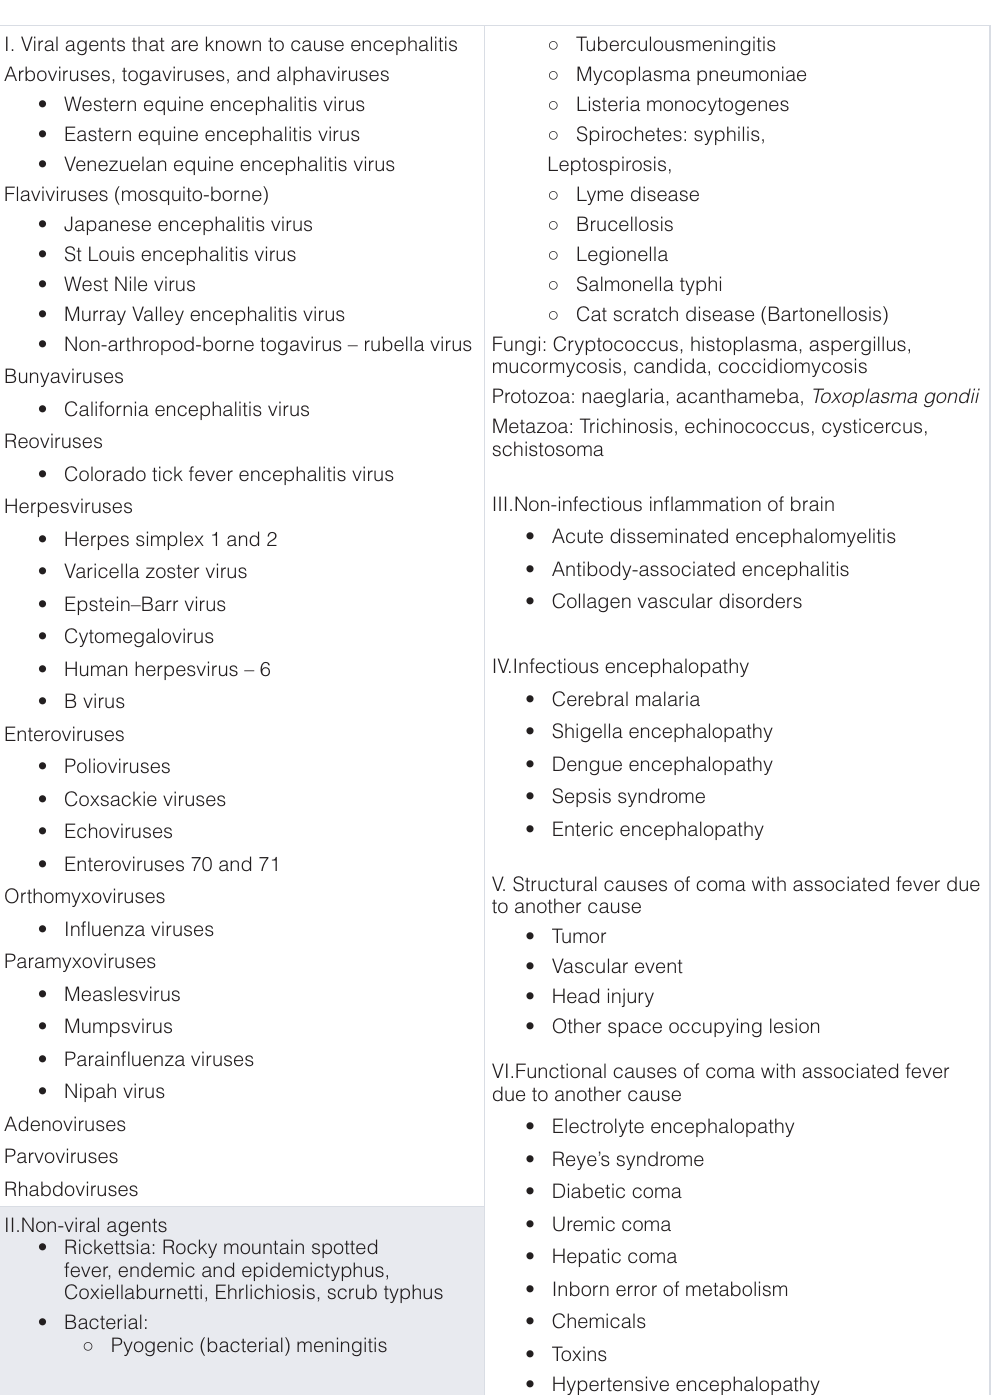
Table 1. Etiology of acute encephalitis